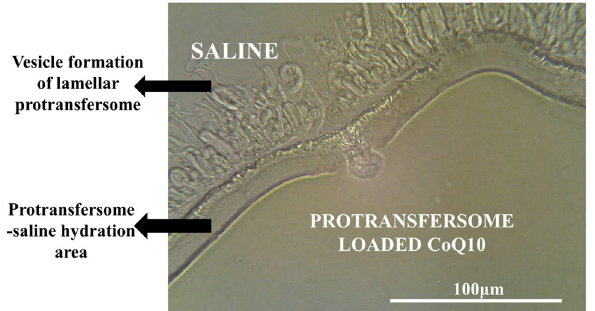
Figure 1. Lamellar structure of liquid crystals of the CoQ10 protransfersome emulgel after adding one drop of saline under an optical microscopy observation at × 400 magnification (Scale bar:100 μm).